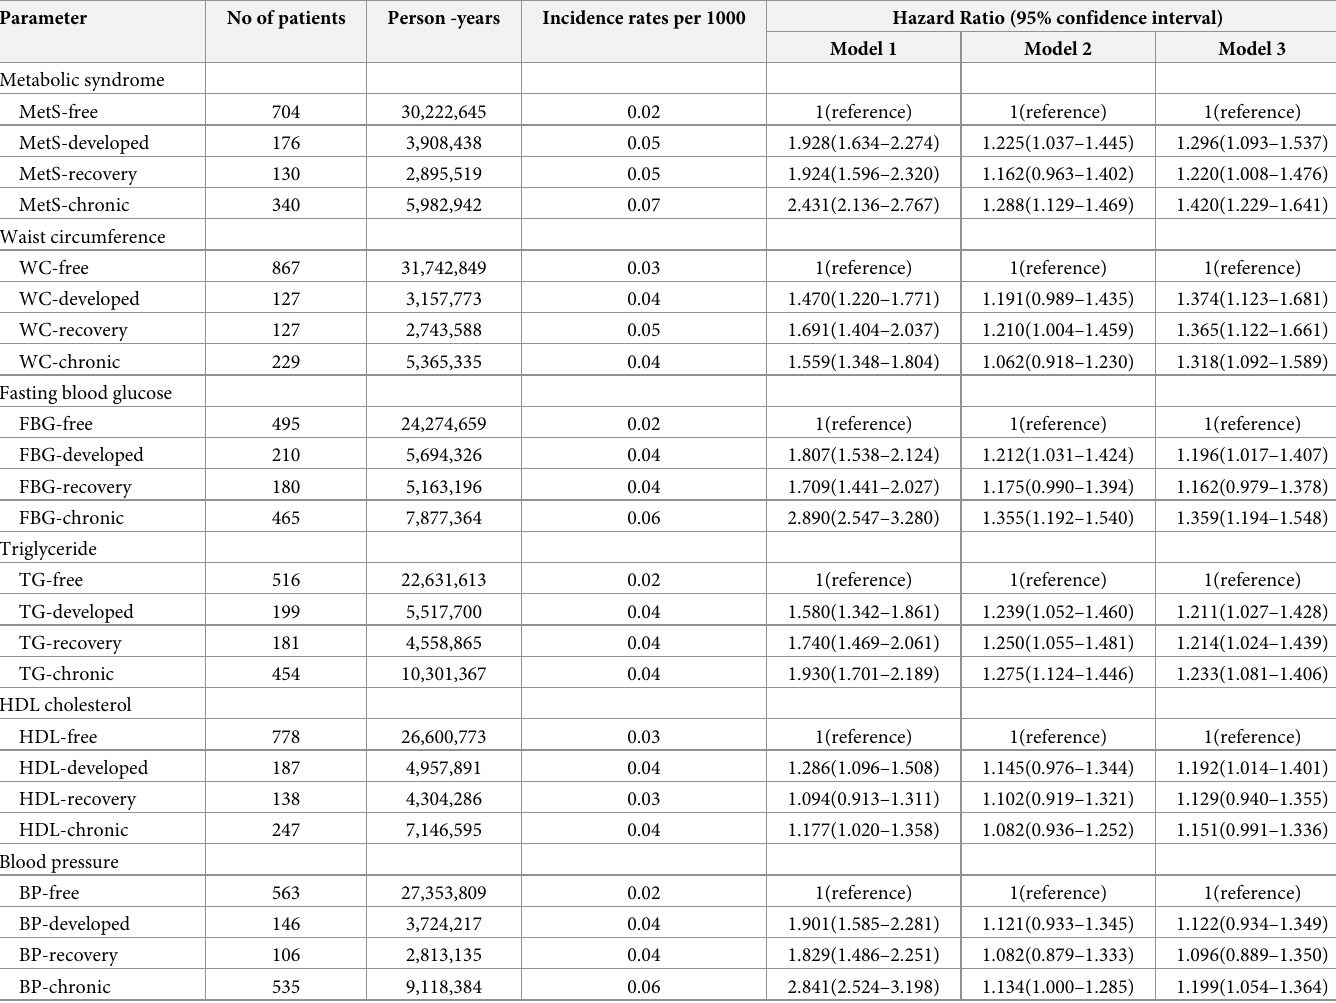
Table 3. Multivariate Cox proportional hazard model for larynx cancer risk according to changes in metabolic syndrome and